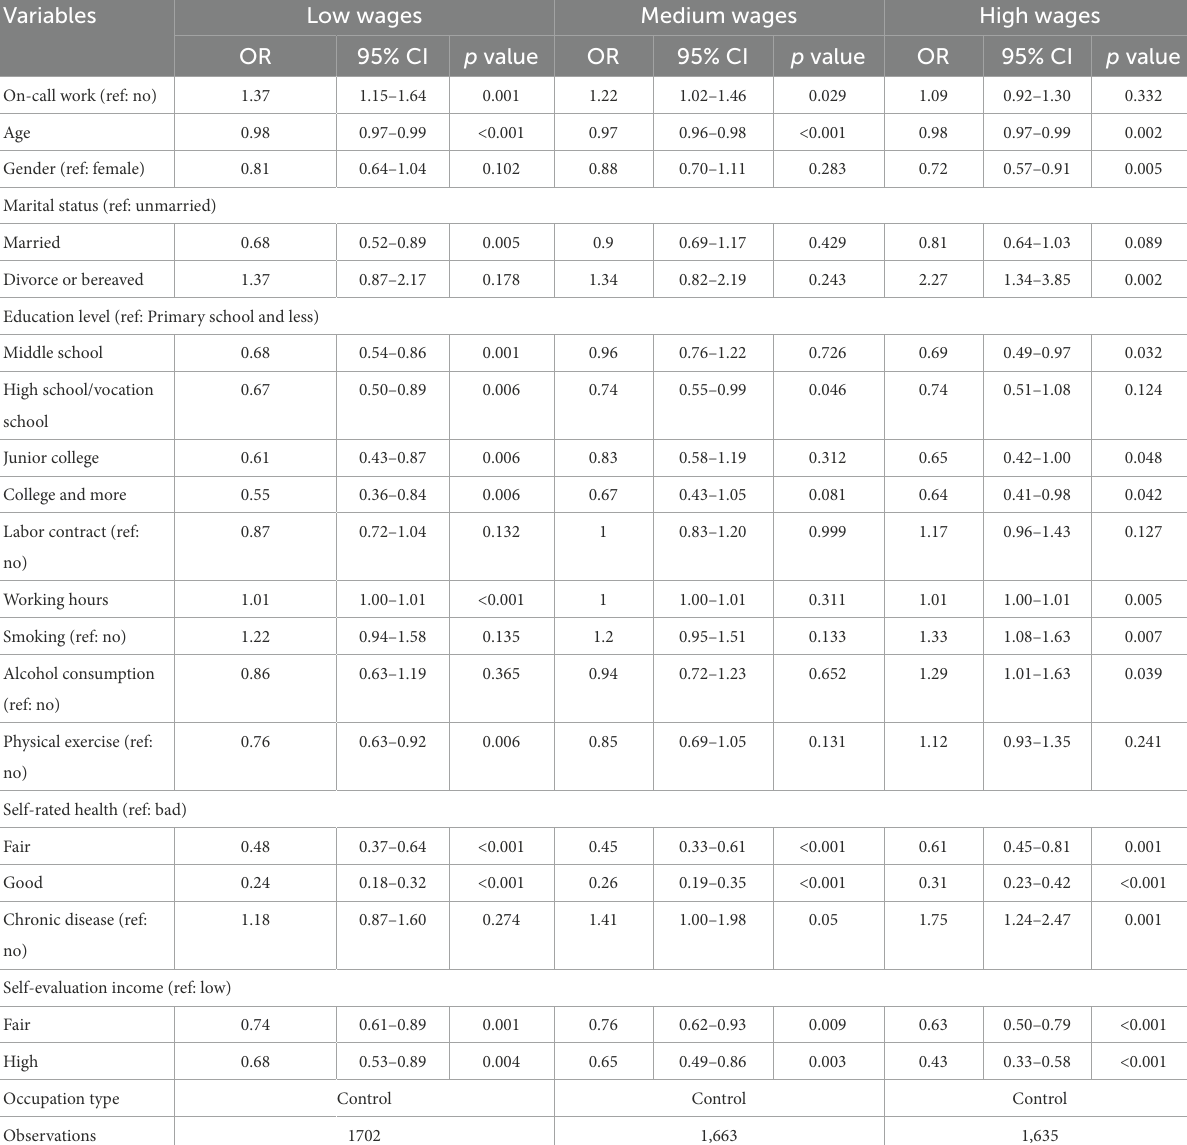
TABLE 7 Associations between on-call work and depressive mood, grouped by income level. Variables Low wages Medium wages High